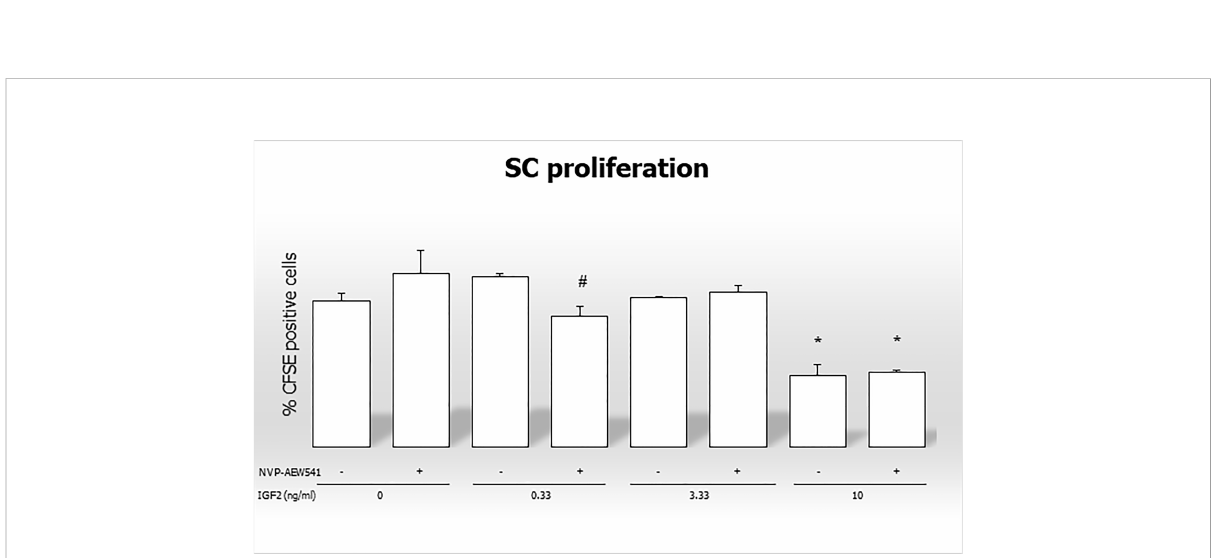
FIGURE 7 Flow cytometric analysis of Sertoli cells stained with CFSE without stimulation, after incubation with IGF2, NVP-AEW541, and IGF2 + NVP- AEW541. *p < 0.05 vs SCs, #p < 0.05 vs 0.33 ng/ml of